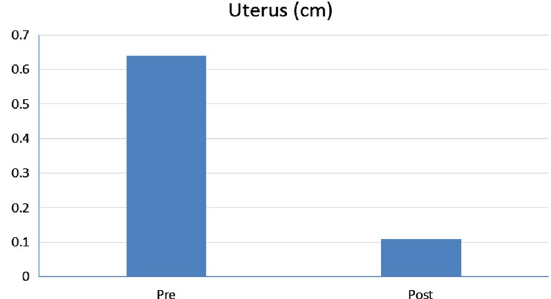
Fig. 4 Bar graph demonstrating the mean of uterine descent below PCL in both pre- and postoperative